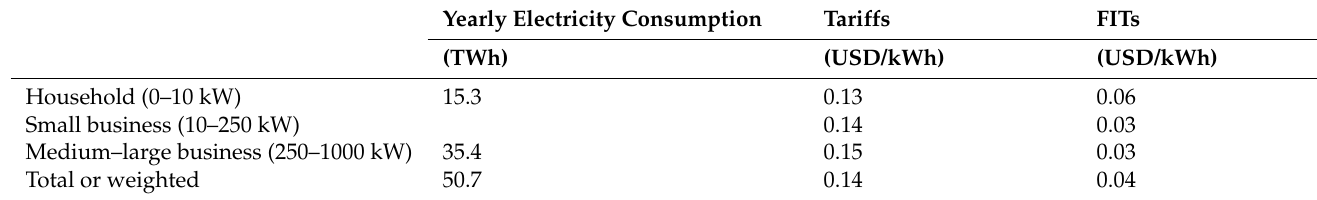
Table 3. Annual electricity consumption, electricity tariffs, and FITs in Bangkok City in 2020. Data are from [57–60]. A fuel adjustment charge was added at a rate of 0.025 USD · kWh − 1 . In addition, a 7% tax fee was added to the tariff. Weighted tariff and FIT prices were calculated from electricity consumption.